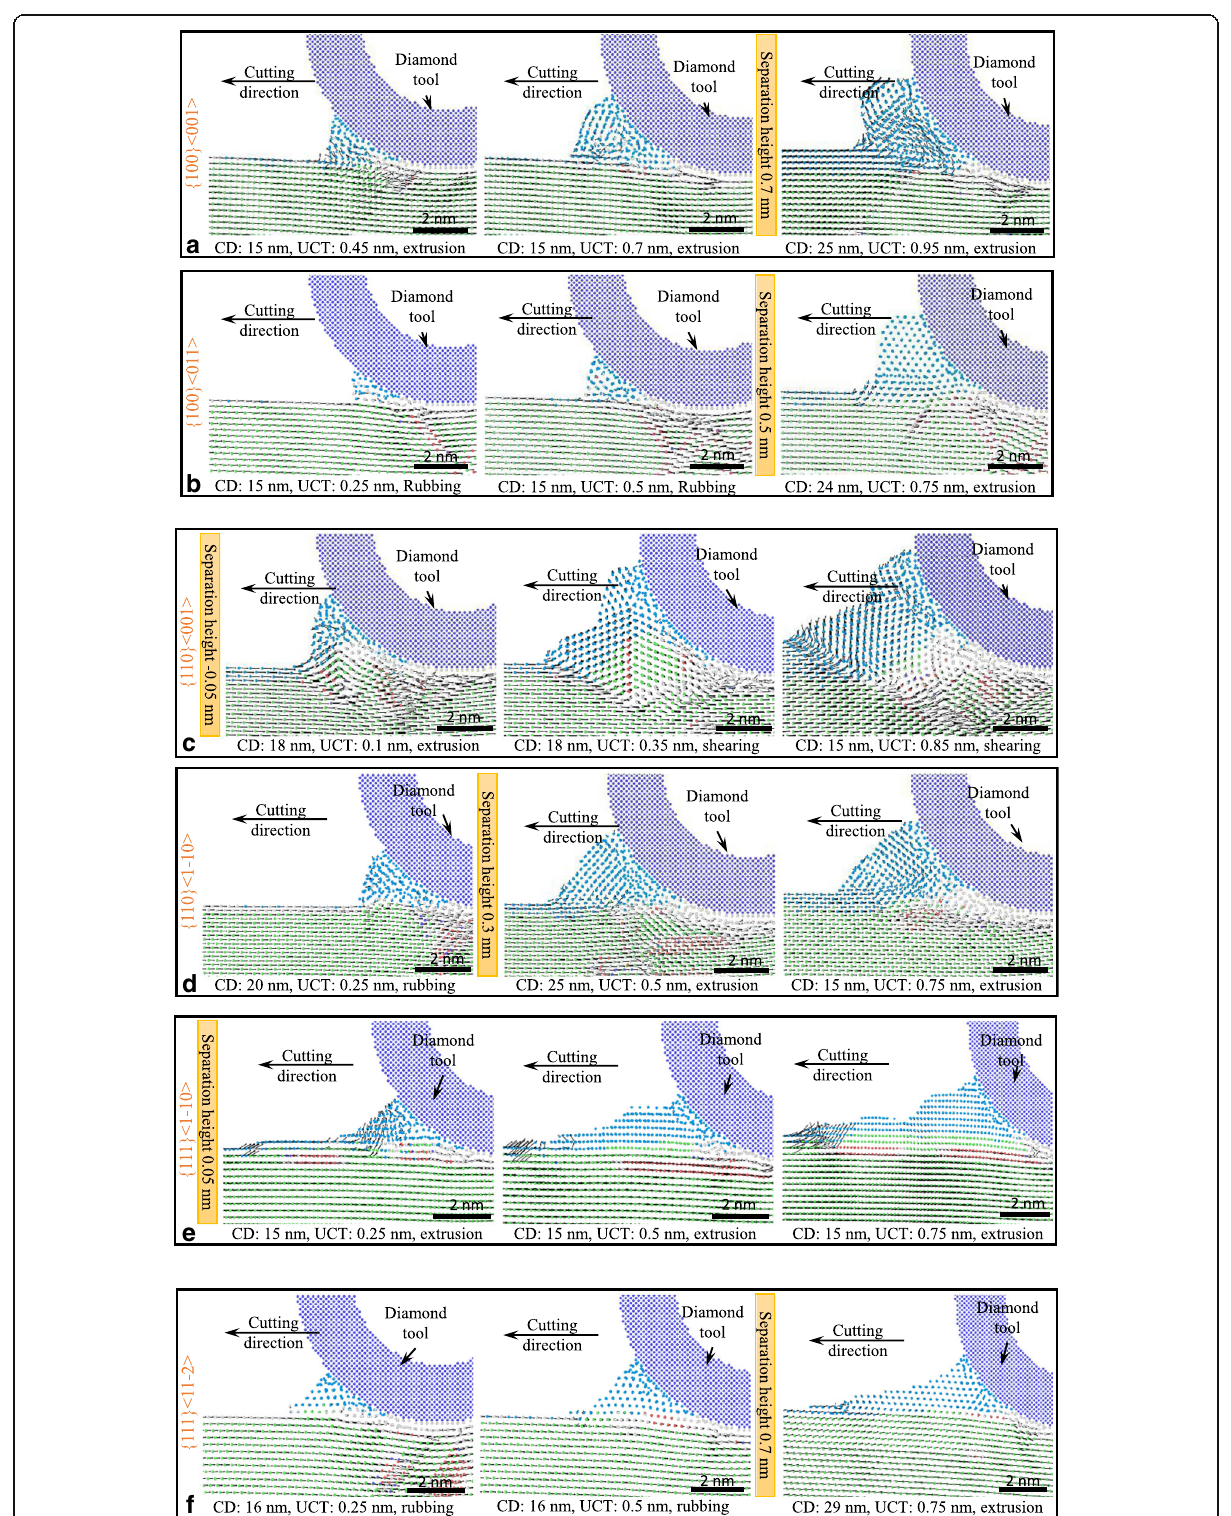
Fig. 13 Displacement vectors at different UCT and cutting directions: a {100}<001>, b {100}<011>, c {110}<001>, d {110}<1-10>, e {111}<1-10>, f {111}<11-2>, making the material remove in rubbing or extrusion